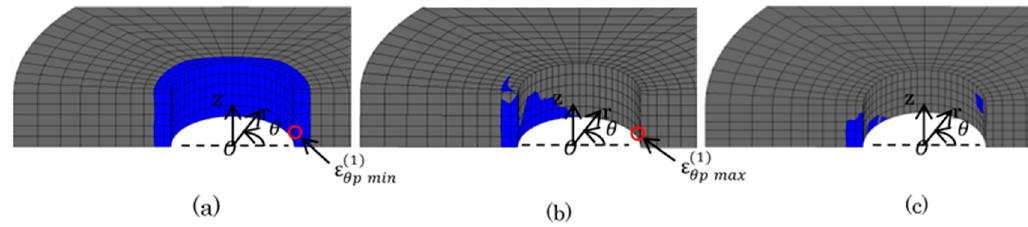
( b ) tensile state; ( c ) sprocket-engaging state.